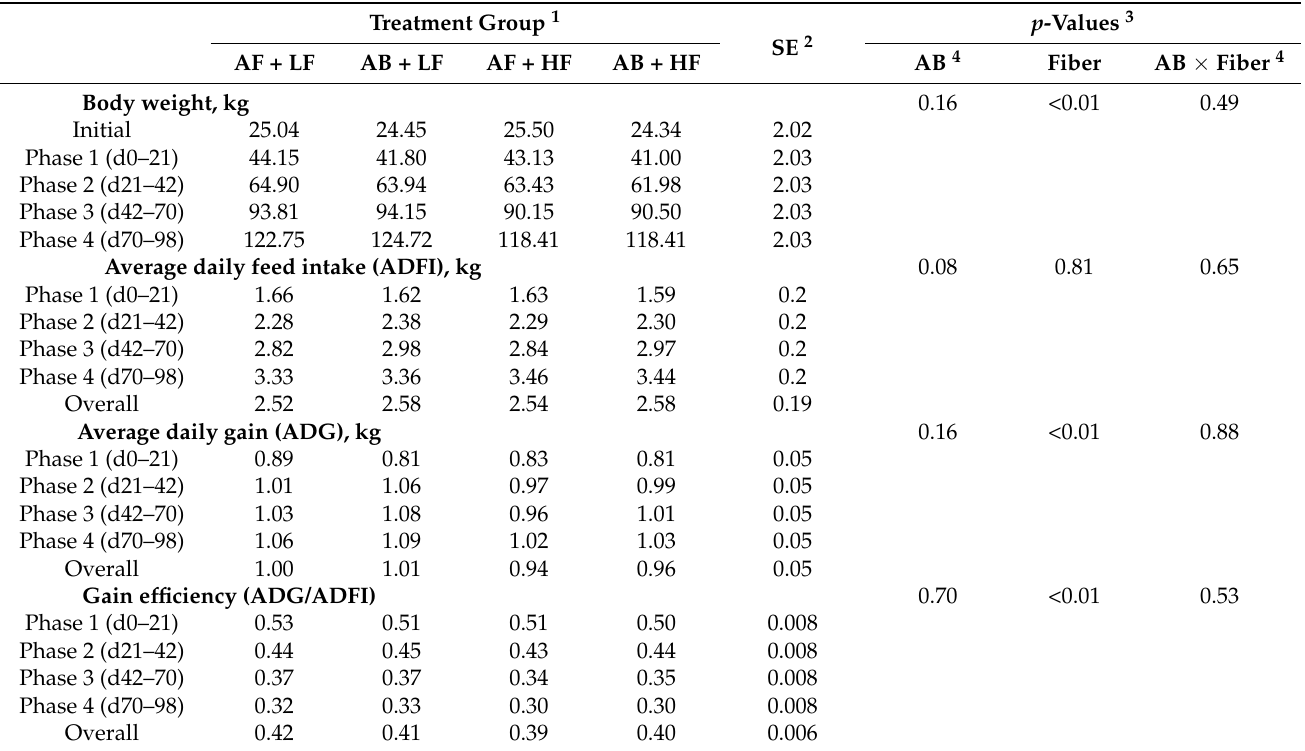
Table 1. Growth performance of pigs fed diets containing fiber and